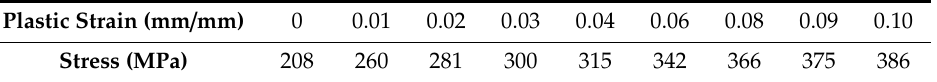
Table 3. The stress values versus the plastic strains for the base